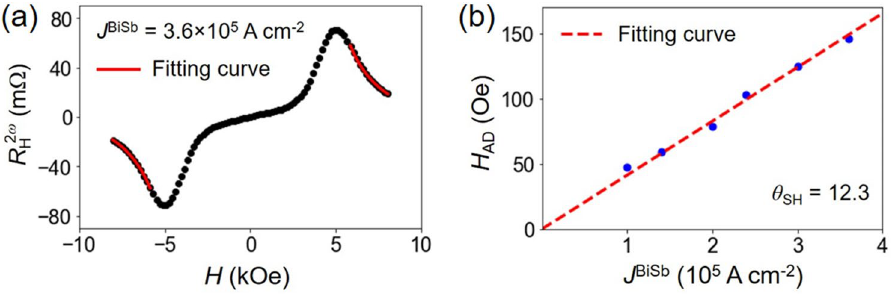
Figure 2. Evaluation of the spin Hall angle by the second harmonic measurements. ( a ) 2nd harmonic Hall resistance as a function of the in-plane external magnetic field H applied along the x direction. The red curves are the theoretical fitting using Eq. (1). ( b ) H AD as a function of J BiSb .